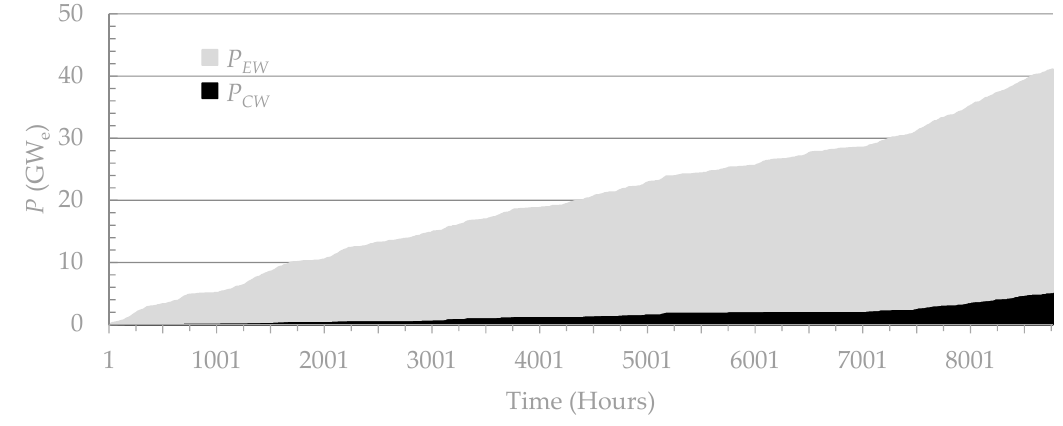
Figure 5. Cumulative wind power profile of a sample wind farm.